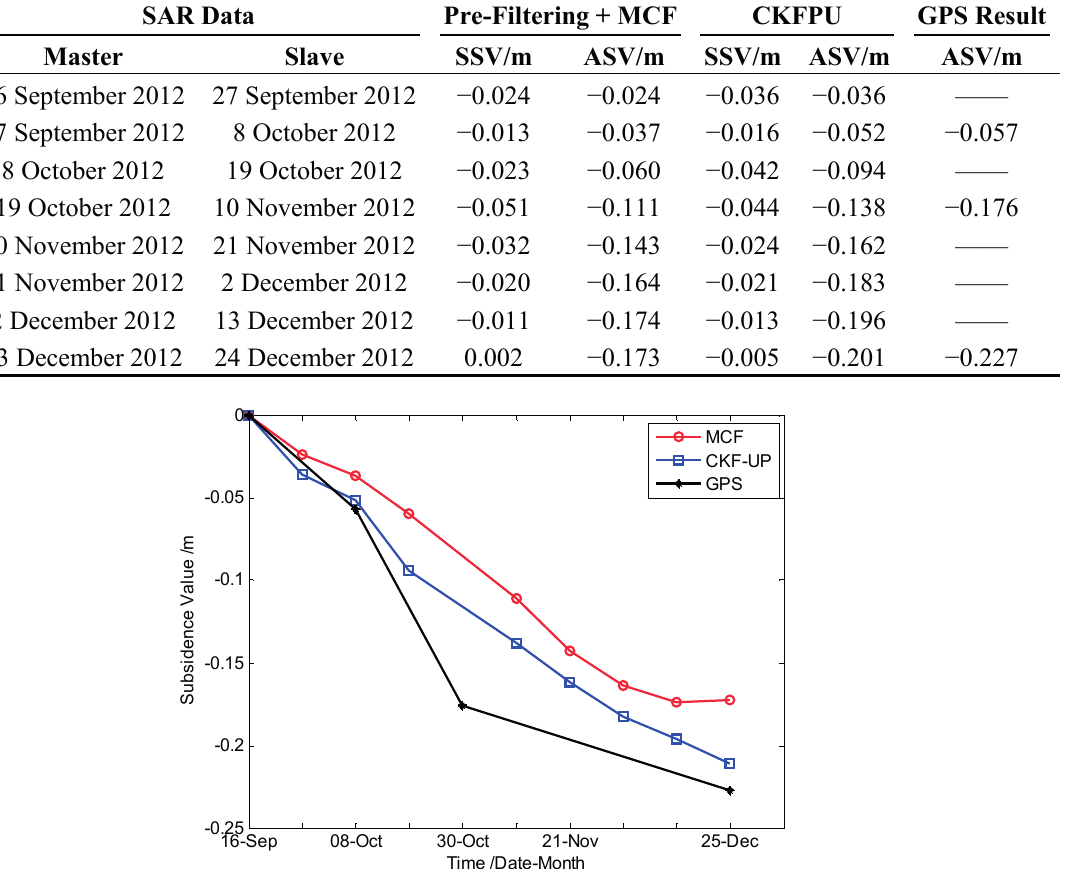
Figure 8. Time series displacement of a Corner Reflector over 88 days, derived from MCF, CKFPU and